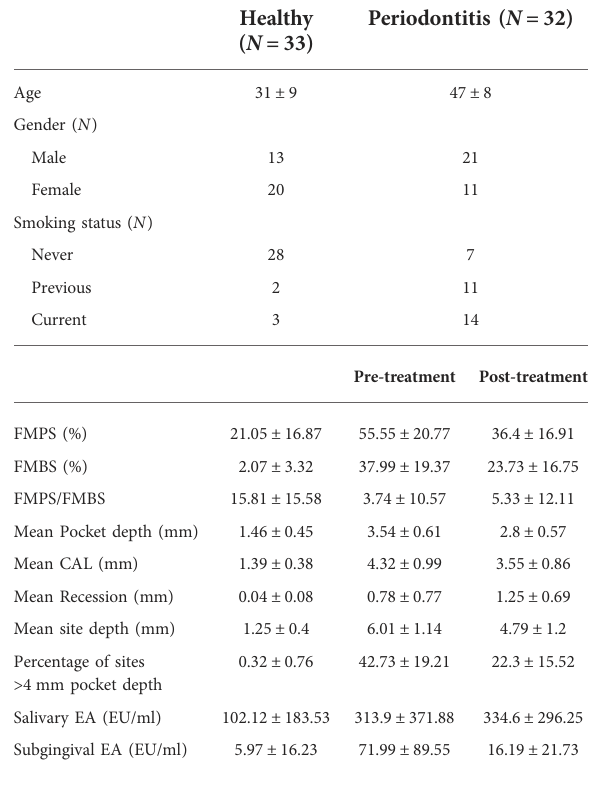
TABLE 1 Demographic, clinical and endotoxin activity characteristics (with SDs) of the study population with differences between pre- and post-treatment in the periodontitis group. Endotoxin activity (EA) expressed in endotoxin units per ml (EU/ml).